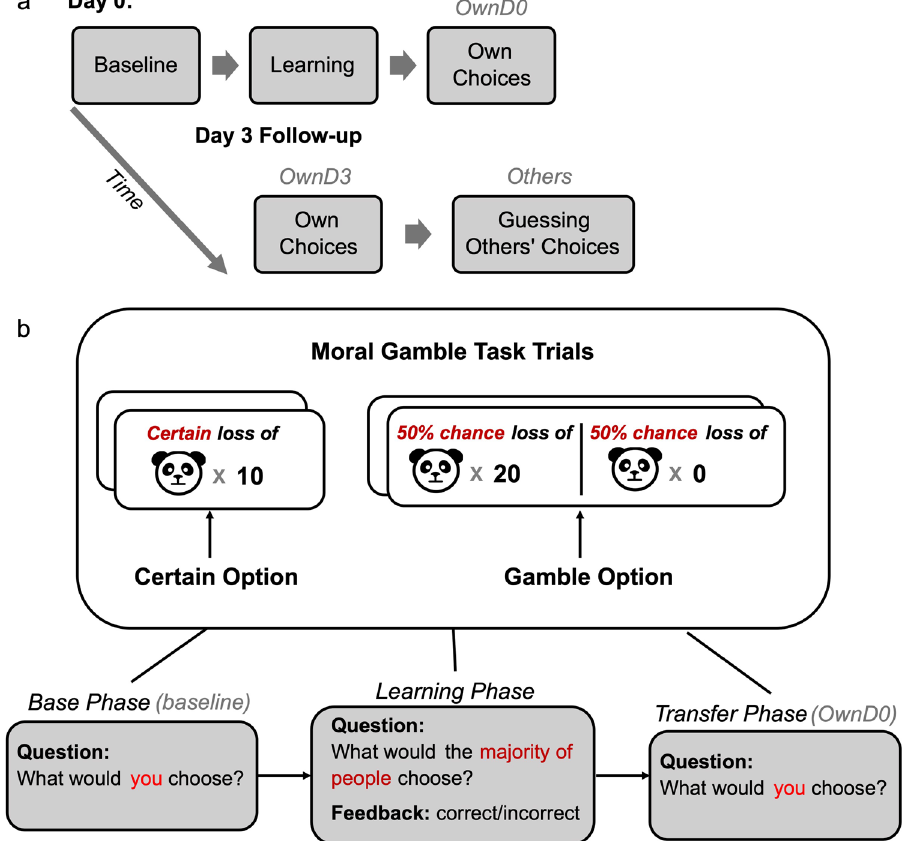
Figure 1. General study procedure. ( a ) At day 0 session, participants completed baseline, learning and transfer phases. At day 3 follow-up session, participants indicated own choices again (same decision scenarios as in the baseline) and guessed the group’s choices (same decision scenarios as in the learning phase). ( b ) In each trial of the moral gamble task, participants chose between a certain option and a gamble option for own choices. In gray, we show the questions asked in the task trials for each phase at day 0. In the learning phase, participants were given feedback regarding their guessing